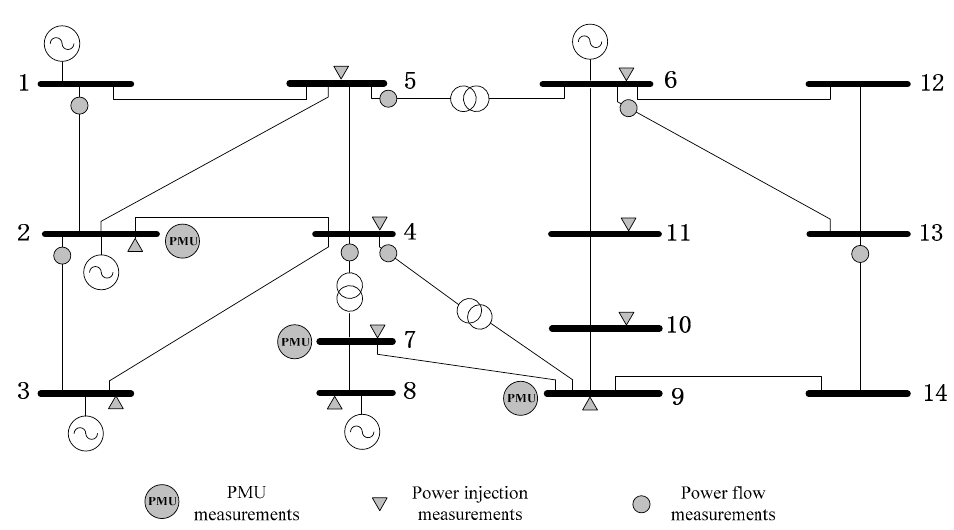
Figure 8. Simulation measurement configuration of the IEEE 14 bus system. Table 1. Bus voltage amplitude estimation of the four methods used in the 14 bus system.